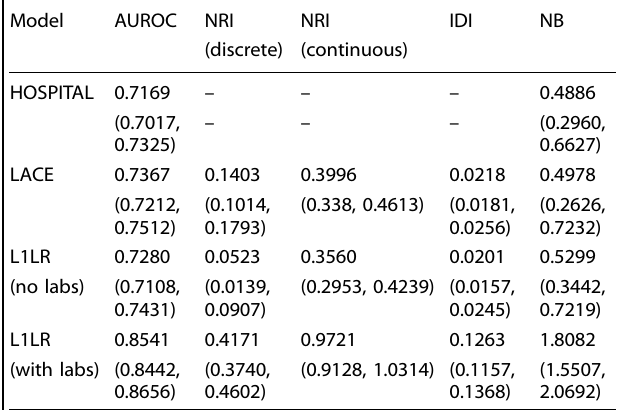
Table 1. Predictive metrics for the four